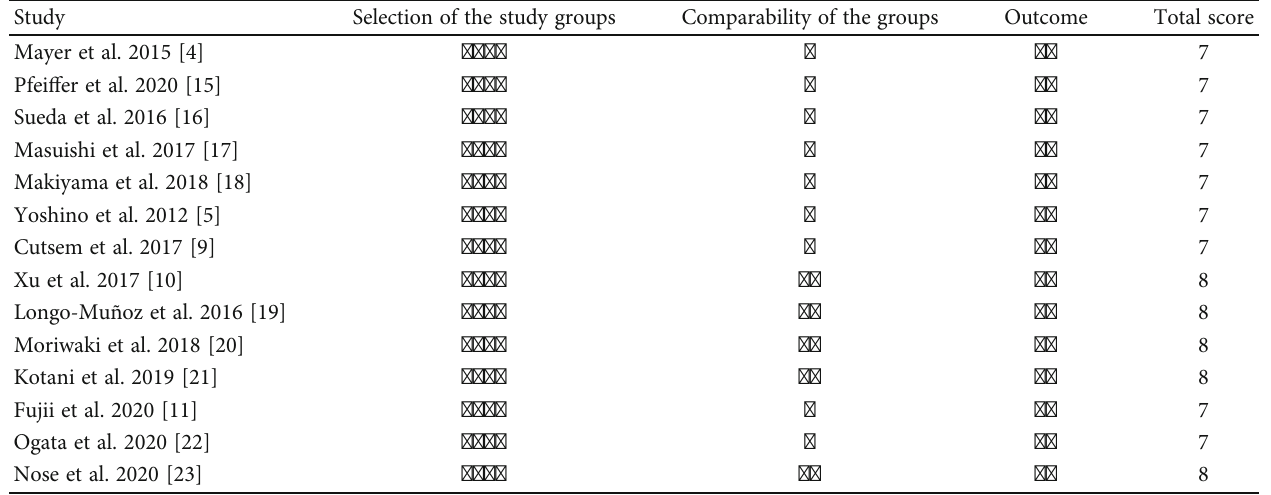
Table 2: The Newcastle-Ottawa Quality Assessment Scale for included controlled